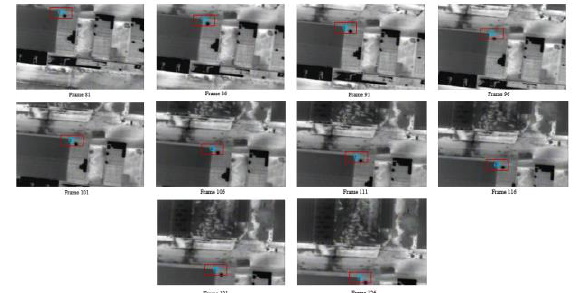
Figure 9: Target tracked in the sequence of successive frames